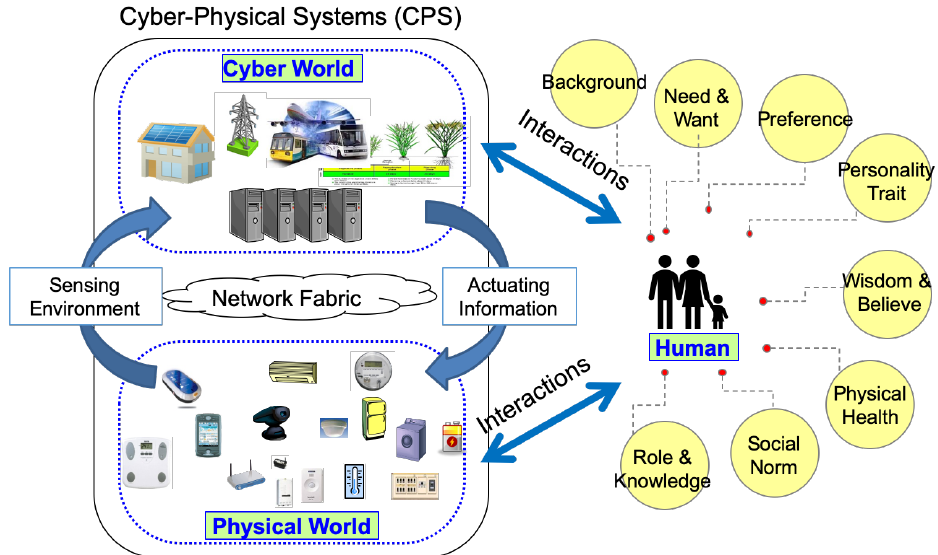
Figure 1. The schematic diagram of cyber–physical human centric system (CPHCS).